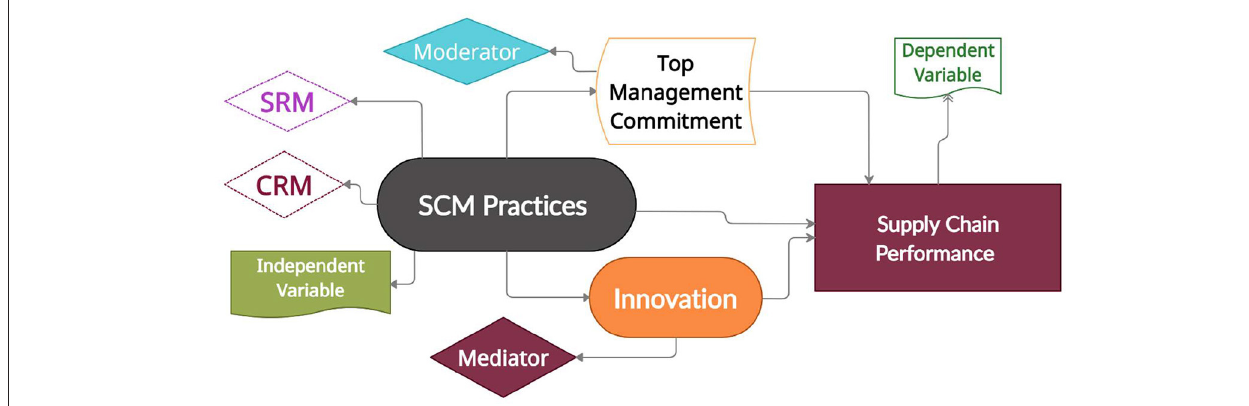
FIGURE 1 | Conceptual framework.